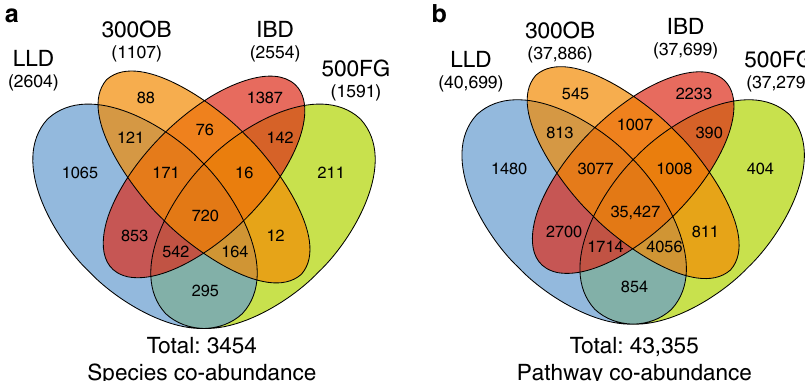
Fig. 2 Microbial co-abundance networks in each cohort. a Venn diagram of the numbers of species co-abundances detected in each cohort. In total, we identi fi ed 3454 co-abundance relationships signi fi cant at FDR < 0.05 in at least one cohort by combing SparCC and SpiecEasi. b Venn diagram of the numbers of species co-abundances detected in each cohort. Similarly, at the microbial metabolic pathway level, 43,355 co-abundance relationships were detected at FDR < 0.05 in at least one cohort by combing SparCC